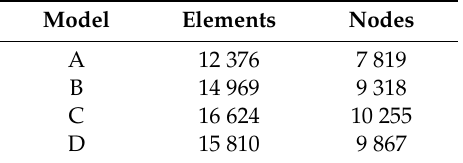
Table 2. Number of elements and nodes in the di ff erent 2D FE models of